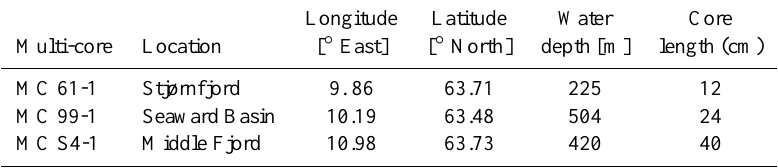
Table 1. Site locations, water depths and core